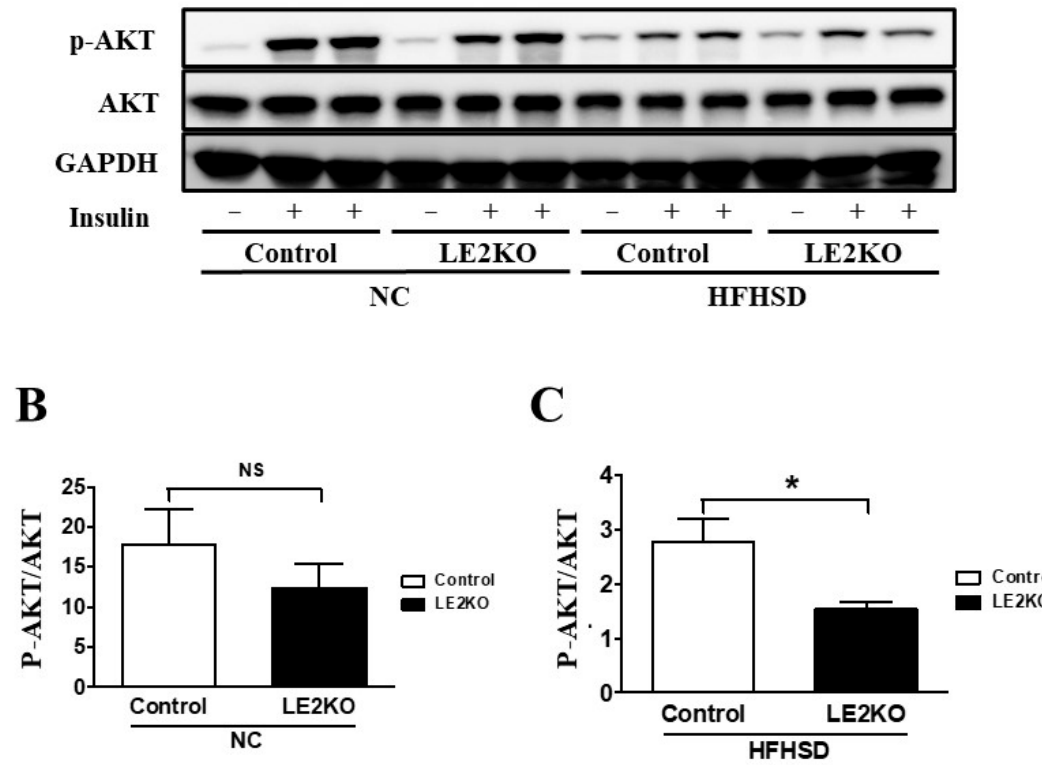
Figure 3. HFHSD-LE2KO have impaired insulin sensitivity in skeletal muscle. ( A ) Phosphorylation of AKT (Ser 473) in the soleus muscle of controls and LE2KO on NC or HFHSD, respectively ( n = 3 for each group). ( B , C ) Quantification of phosphorylation of AKT/AKT on NC or HFHSD. Error bars represent SEM; p values were determined by t-test (* p < 0.05, vs. control).